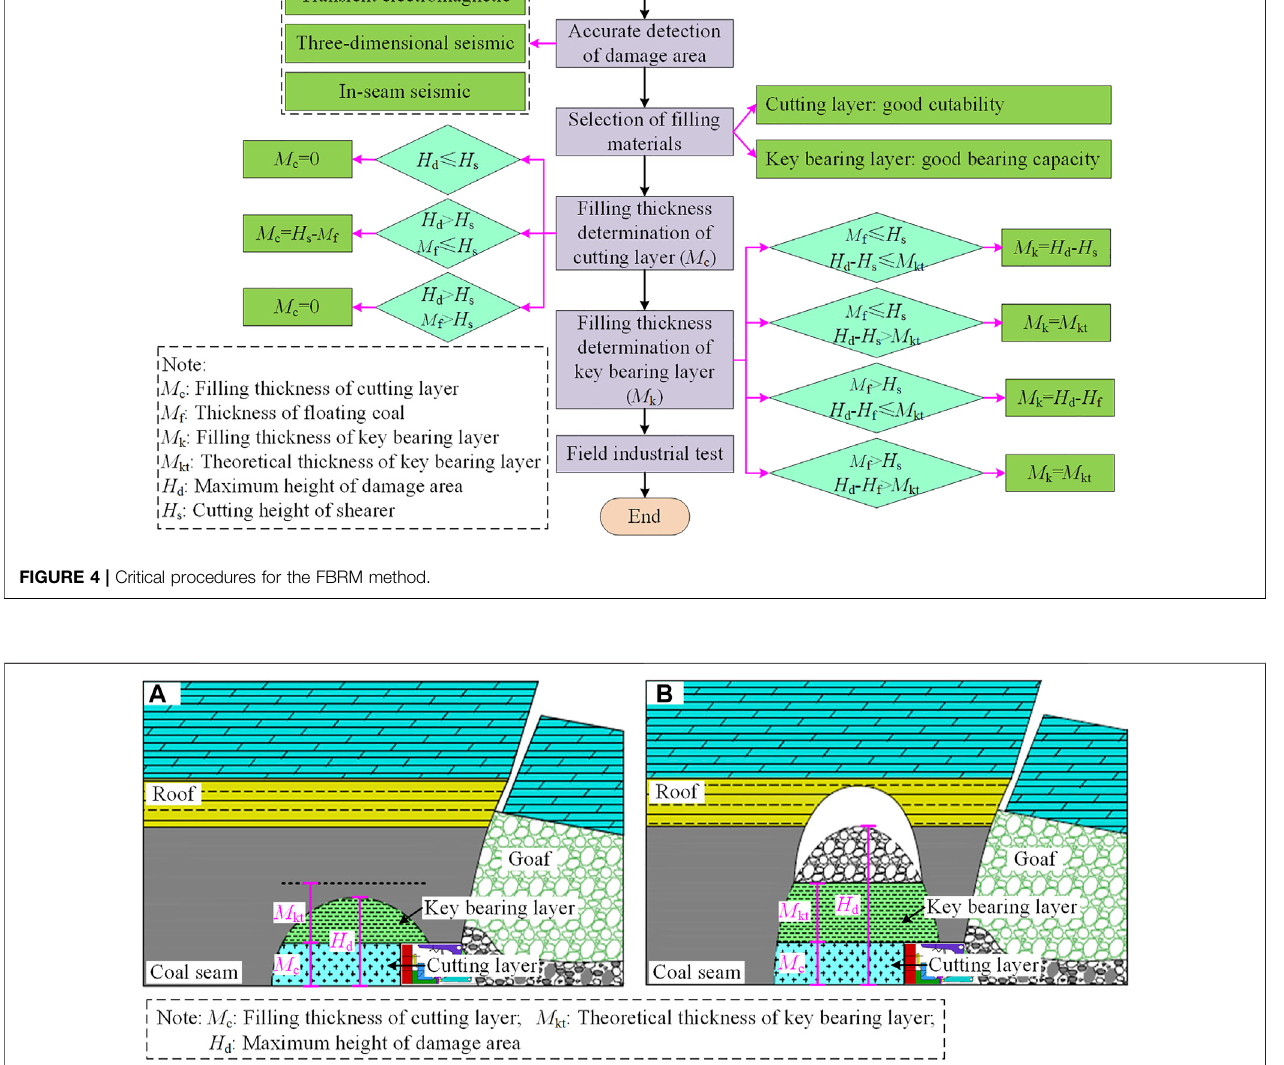
Frontiers in Earth Science |